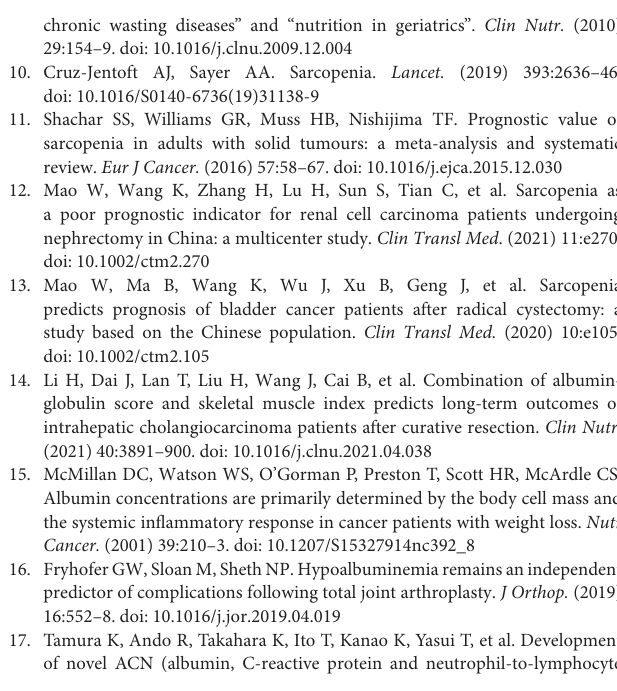
Supplementary Figure 1 | Kaplan-Meier curves for OS and CSS stratified by AGR, AGS and SMI in the test set. A and D , AGR OS and CSS; B and E , AGS OS and CSS; C and F , SMI OS and CSS. OS, overall survival; CSS, cancer-specific survival; AGR, albumin to globulin ratio; AGS, albumin-globulin score; SMI, skeletal muscle index. Supplementary Figure 2 | Kaplan-Meier curves for OS and CSS stratified by CAS grade in the test set. A , CAS OS; B , CAS CSS. OS, overall survival; CSS, cancer-specific survival; CAS, combination of albumin-globulin score and sarcopenia. Supplementary Figure 3 | Comparison of area under ROC curves for AGR, AGS, SMI and CAS grade in predicting OS and CSS in the test set. A , OS ROC curves; B , CSS ROC curves. OS, overall survival; CSS, cancer-specific survival; ROC, receiver operator characteristic; AUC, area under the curve; AGR, albumin to globulin ratio; AGS, albumin-globulin score; SMI, skeletal muscle index; CAS, combination of albumin-globulin score and